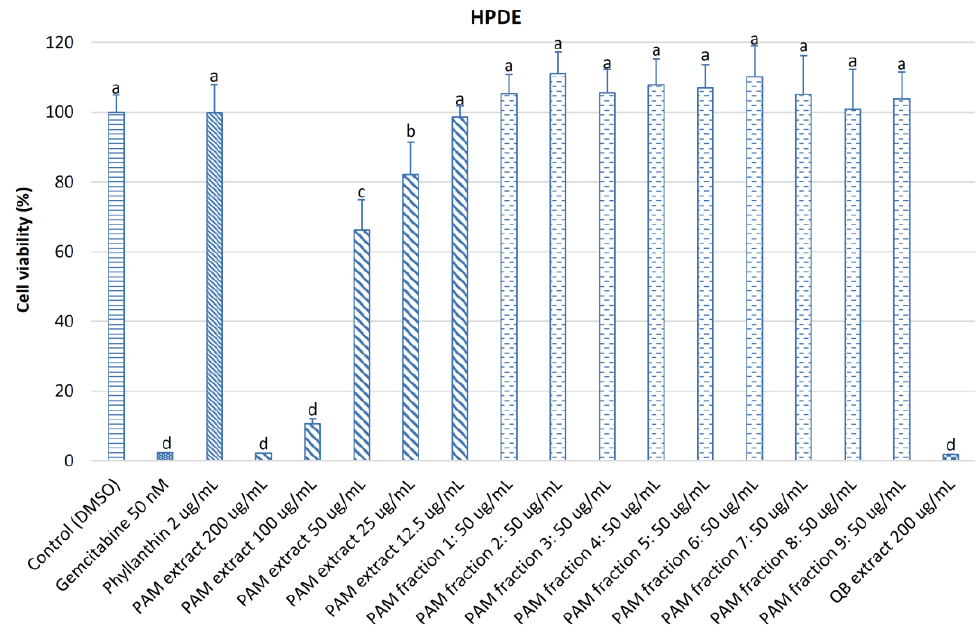
Figure 6. Viability of HPDE cells treated with different concentrations of powdered P. amarus methanol ( PA M) extract and fractions. DMSO was used as a control; gemcitabine and phyllanthin were used as positive controls; and quillajia bark (QB) extract was used as a comparative sample. Different letters within the columns denotes a significant difference between treatments ( p < 0.05).